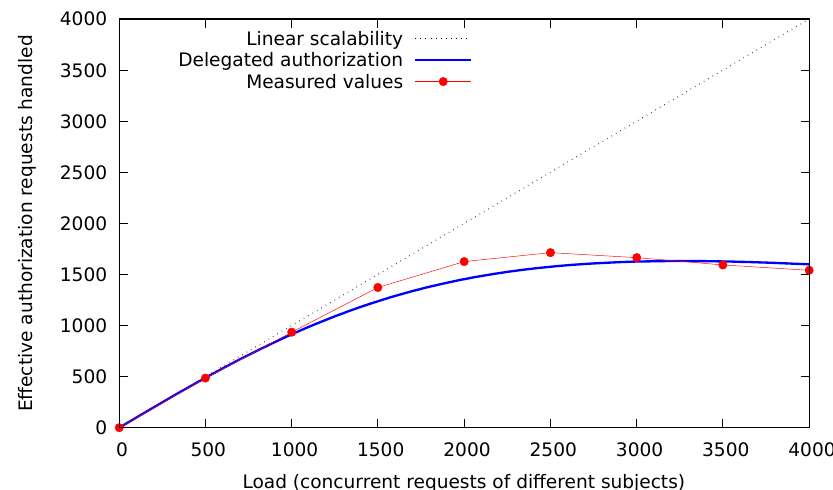
Figure 15. Systematic scalability analysis of delegated policy evaluation with the Universal Scalability Law